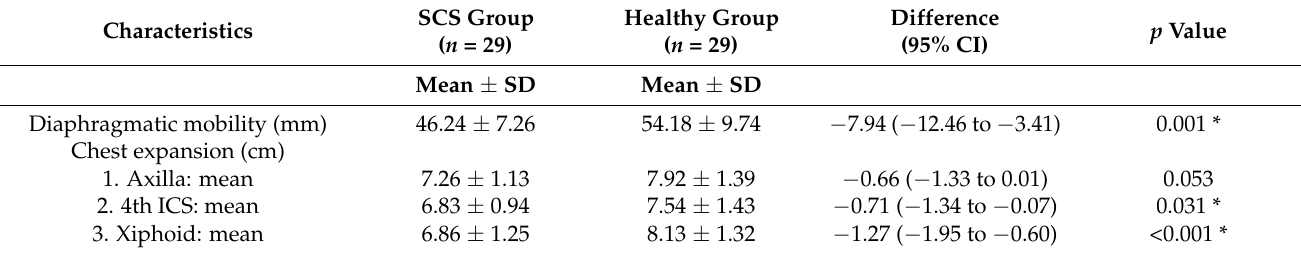
Table 2. Diaphragmatic mobility and chest expansion between the SCS group and the healthy